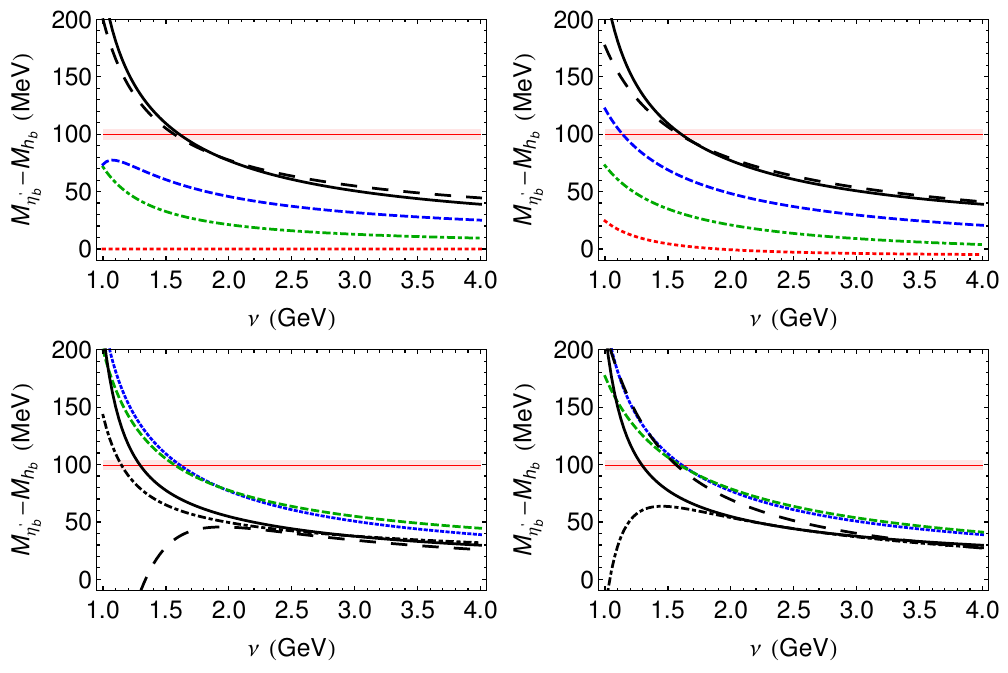
Figure 12 . Plot of M (cid:0) M h in MeV in RS’ scheme for (cid:23) f = 1 GeV, m b; RS 0 = 4 : 885 GeV. Red (cid:17) 0 b b band is the experimental value. Upper left panel: (cid:23) r = 1 GeV. Red dotted, green dot-dashed, blue dashed and black long-dashed are the results obtained solving eq. (4.1) with the static potential truncated at N=0,1,2,3, respectively. Solid black line is the N = 3 previous result in strict (cid:12)xed- order perturbation theory. Upper right panel: as in the upper left panel but with (cid:23) r = 1 GeV. Lower left panel: (cid:23) r = 1 GeV. Blue dotted line corresponds to the solid black line of the above (cid:12)gure, green short-dashed line corresponds to the long-dashed black line of the above (cid:12)gure. The other lines incorporate the relativistic and ultrasoft corrections. Solid black line is the full result in strict (cid:12)xed-order perturbation theory (solid black line in the right panel in (cid:12)gure 7). The long-dashed black line corresponds to eq. (4.7) evaluating the relativistic corrections with the wave function obtained from the N = 3 static potential. The dot-dashed black line corresponds to eq. (4.7) evaluating the O ( mv 4 ) relativistic corrections with the wave function obtained from the N = 1 static potential and the O ( mv 4 (cid:11) s ) relativistic corrections with the wave function obtained from the N = 0 static potential. Lower right panel: as in the lower left panel but with (cid:23) r = 1